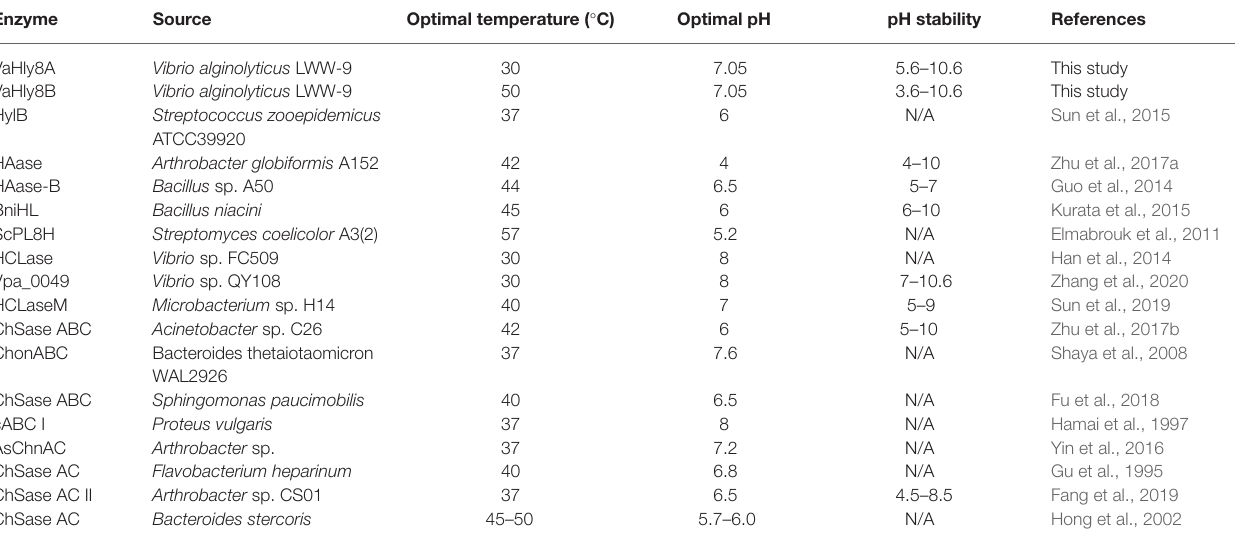
TABLE 2 | Comparison of the biochemical properties of VaHly8A and VaHly8B with other PL8 family enzymes. Enzyme Source Optimal temperature ( ° C) Optimal